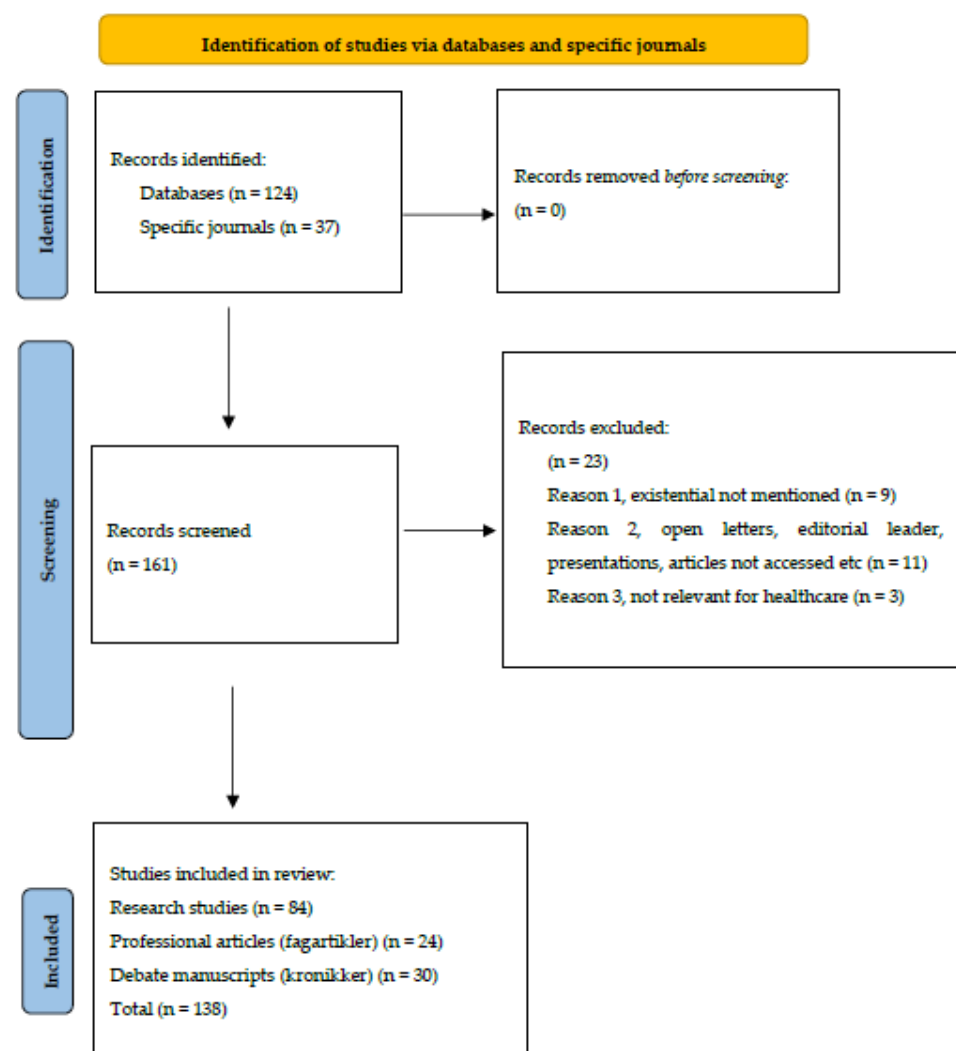
Figure 1. PRISMA flow diagram. The PRISMA Flow diagram is based on the work of Page et al.